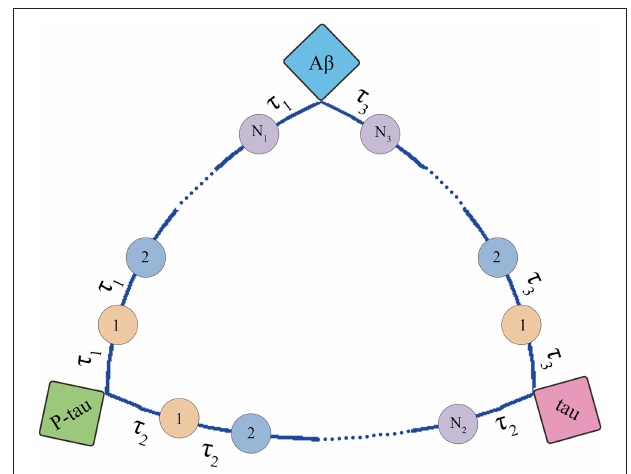
FIGURE 3 | Structure of mini network. Transit compartments with a mean transit time constant τ are used to descript the indirect interactions between these